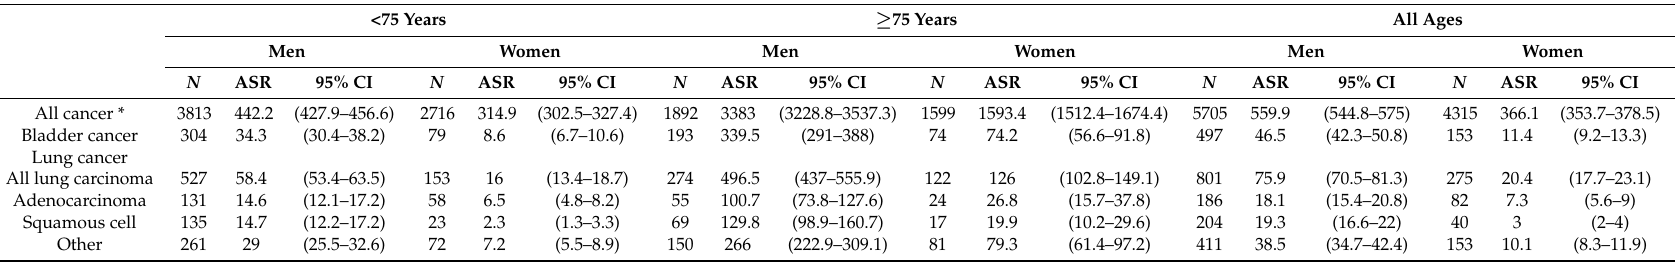
Table 1. Number of incident cases of lung and bladder carcinomas, age-standardized incidence rates (ASR) with corresponding 95% confidence intervals (CI), by sex and age group. 1995–2009 in 14 municipalities.